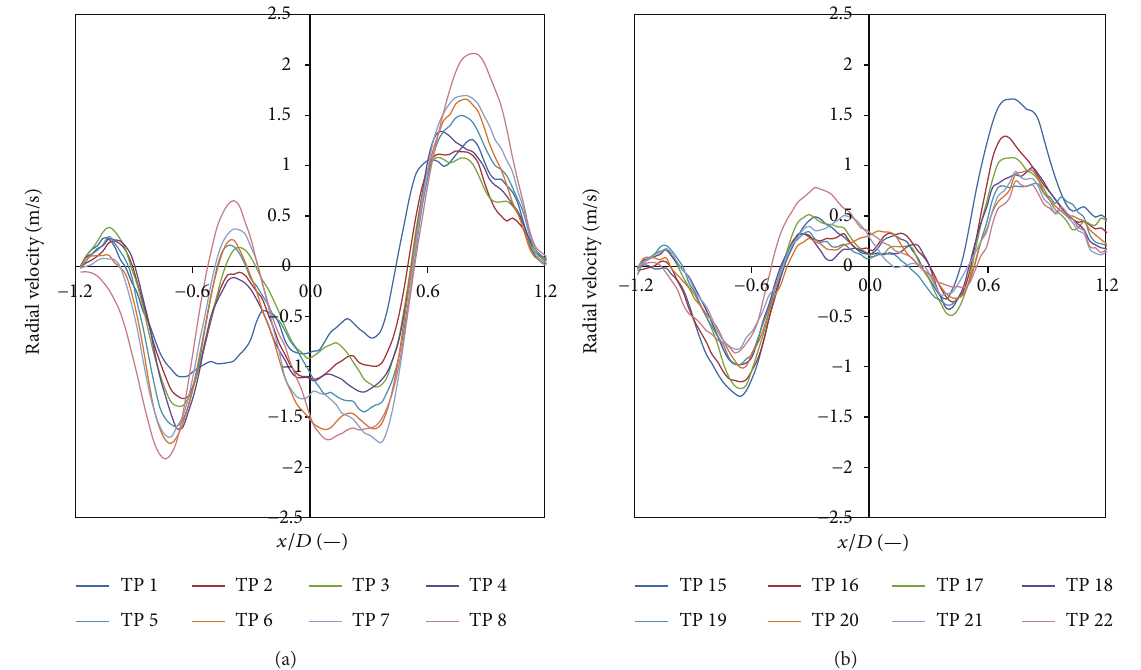
Figure 10: Radial velocities at 𝑦/𝐷 = 0.5 for test points detailed in Table 1 with the diffusive injection of (a) methane and (b) carbon